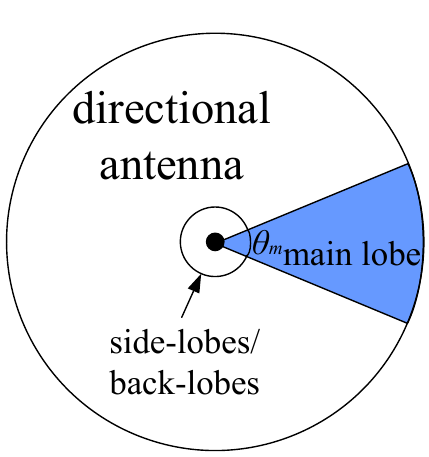
Figure 1. The Antenna